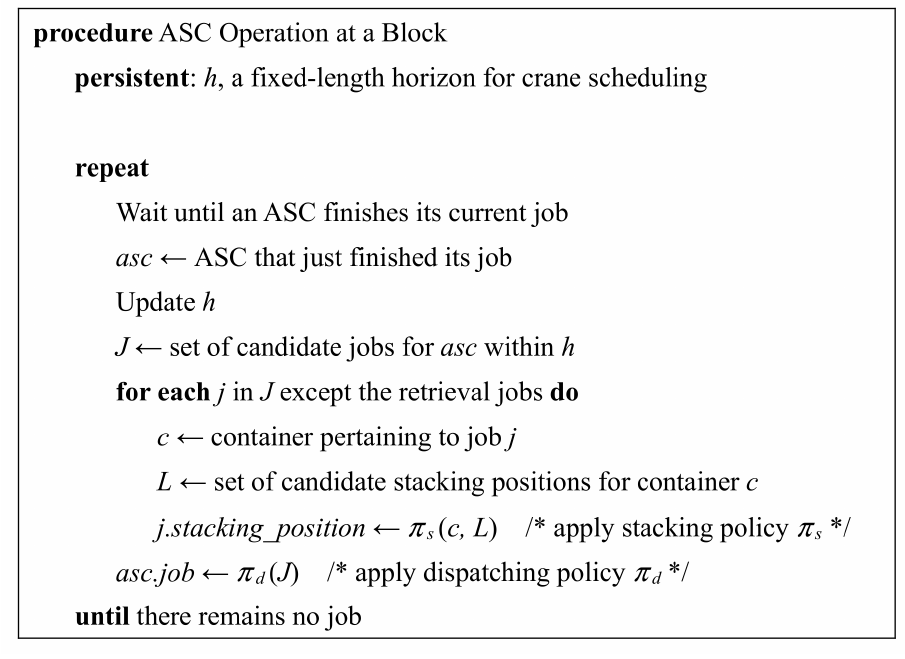
Figure 4. Procedure of ASC operations at a yard block using the stacking and dispatching